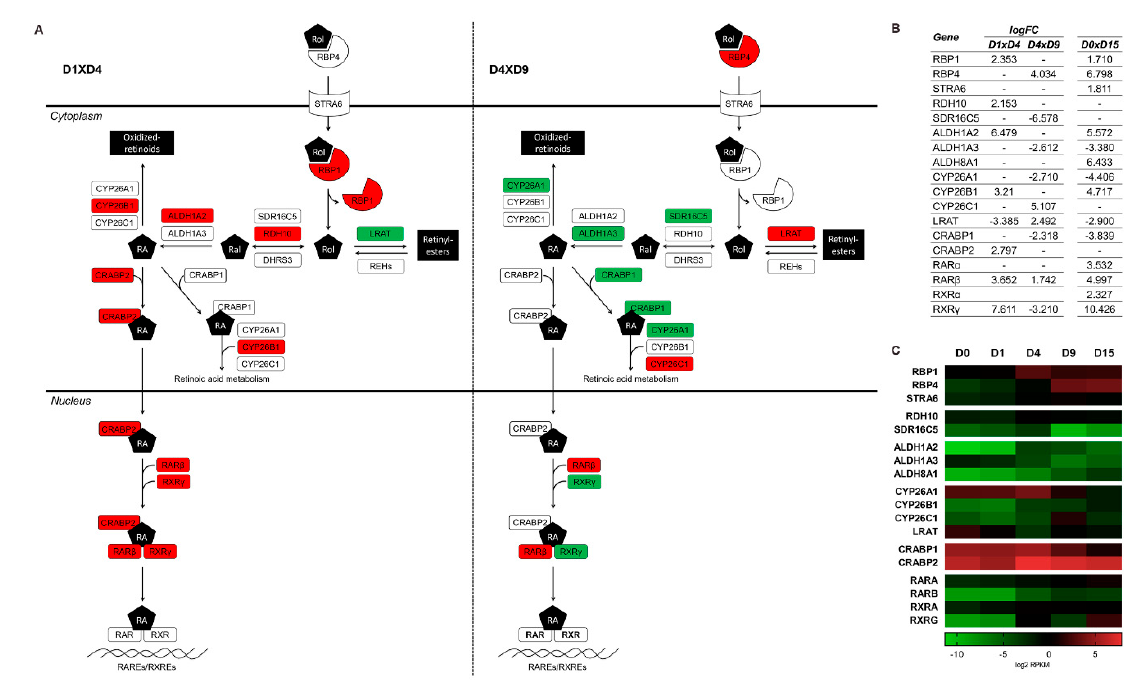
Figure 4. Retinoic acid (RA) synthesis and signaling activation during in vitro cardiac differentiation. ( A ) Comparison of DEGs identified in the RA signaling pathway at the mesoderm (D1 × D4) and cardiac progenitor (D4 × D9) commitment stages. ( B ) Fold change values (log) of the DEGs from the D1 × D4, D4 × D9 and D0 × D15 comparisons. ( C ) Heatmaps representing the gene expression profiles (log2 RPKM values) of DEGs related to RA signaling. Red boxes indicate upregulated genes, while green boxes indicate downregulated genes. Rol: retinol, Ral: retinal. Adapted from Ingenuity Pathway Analysis.